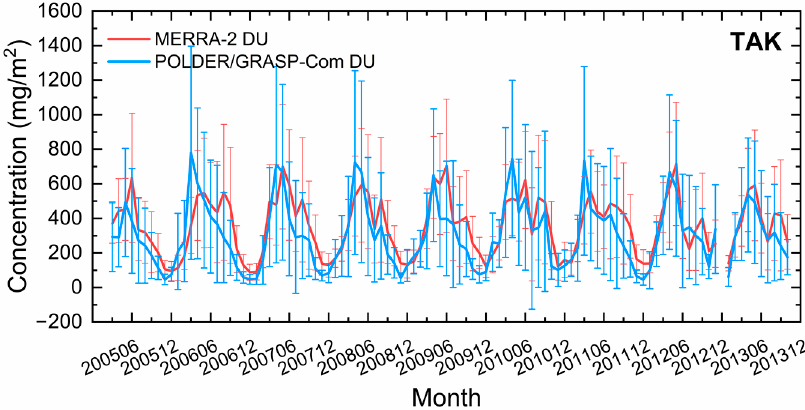
10 of 24 Figure 5 . Same as Figure 3, but for Middle East (MIE) region. 3.1.4. Taklamakan Desert The comparison of the Taklamakan (TAK) desert in northwestern China is shown in Figure 6. We can see that the same variation in monthly means for the calculation of re- gional values is reflected by both GRASP/Component dust retrieval and MERRA-2 dust product. Specifically, GRASP/Component dust retrieval and MERRA-2 dust product pre- sent the same trend of dust column concentration with high values in April and May, whereas there are low values in November, December, and January. A correlation coeffi- cient of 0.80 is found between GRASP/Component dust retrieval and MERRA-2 dust product in the TAK region with RMSE = 122.30 mg/m 2 (in Table 2). The differences in